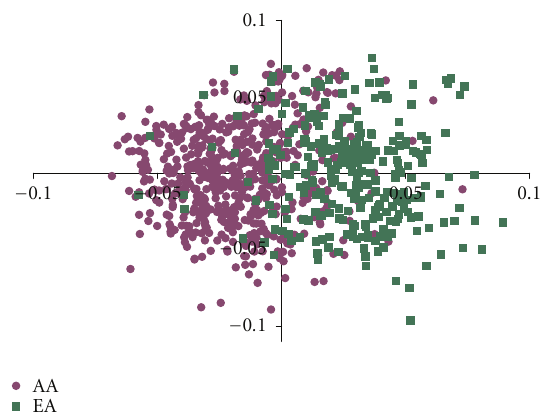
Figure 1: Principal component analysis of SNPs genotyped in all cases and controls. Component 1 is shown on the x -axis, and component 2 is shown on the y -axis. Each dot represents one subject, and the dots are color-coded by the self-reported ancestry of that